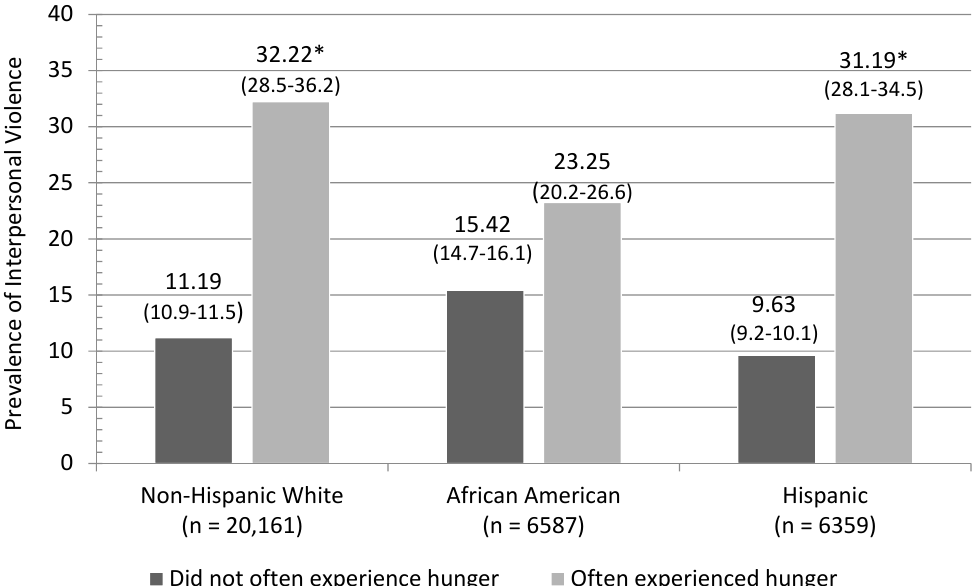
Figure 1. Survey adjusted prevalence estimates of interpersonal violence among individuals who often experienced hunger by race/ethnicity. Differences significant ( p < 0.05) while controlling for sociodemographic, parental, and psychiatric confounds are indicated by the use of an asterisk (*) next to the higher prevalence estimate.